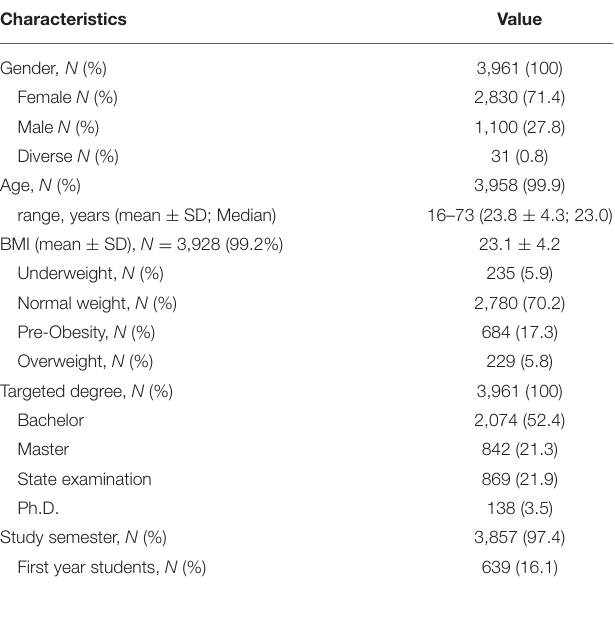
TABLE 1 | Sample characteristics relating to gender, age, BMI, targeted degree and study semester. Characteristics